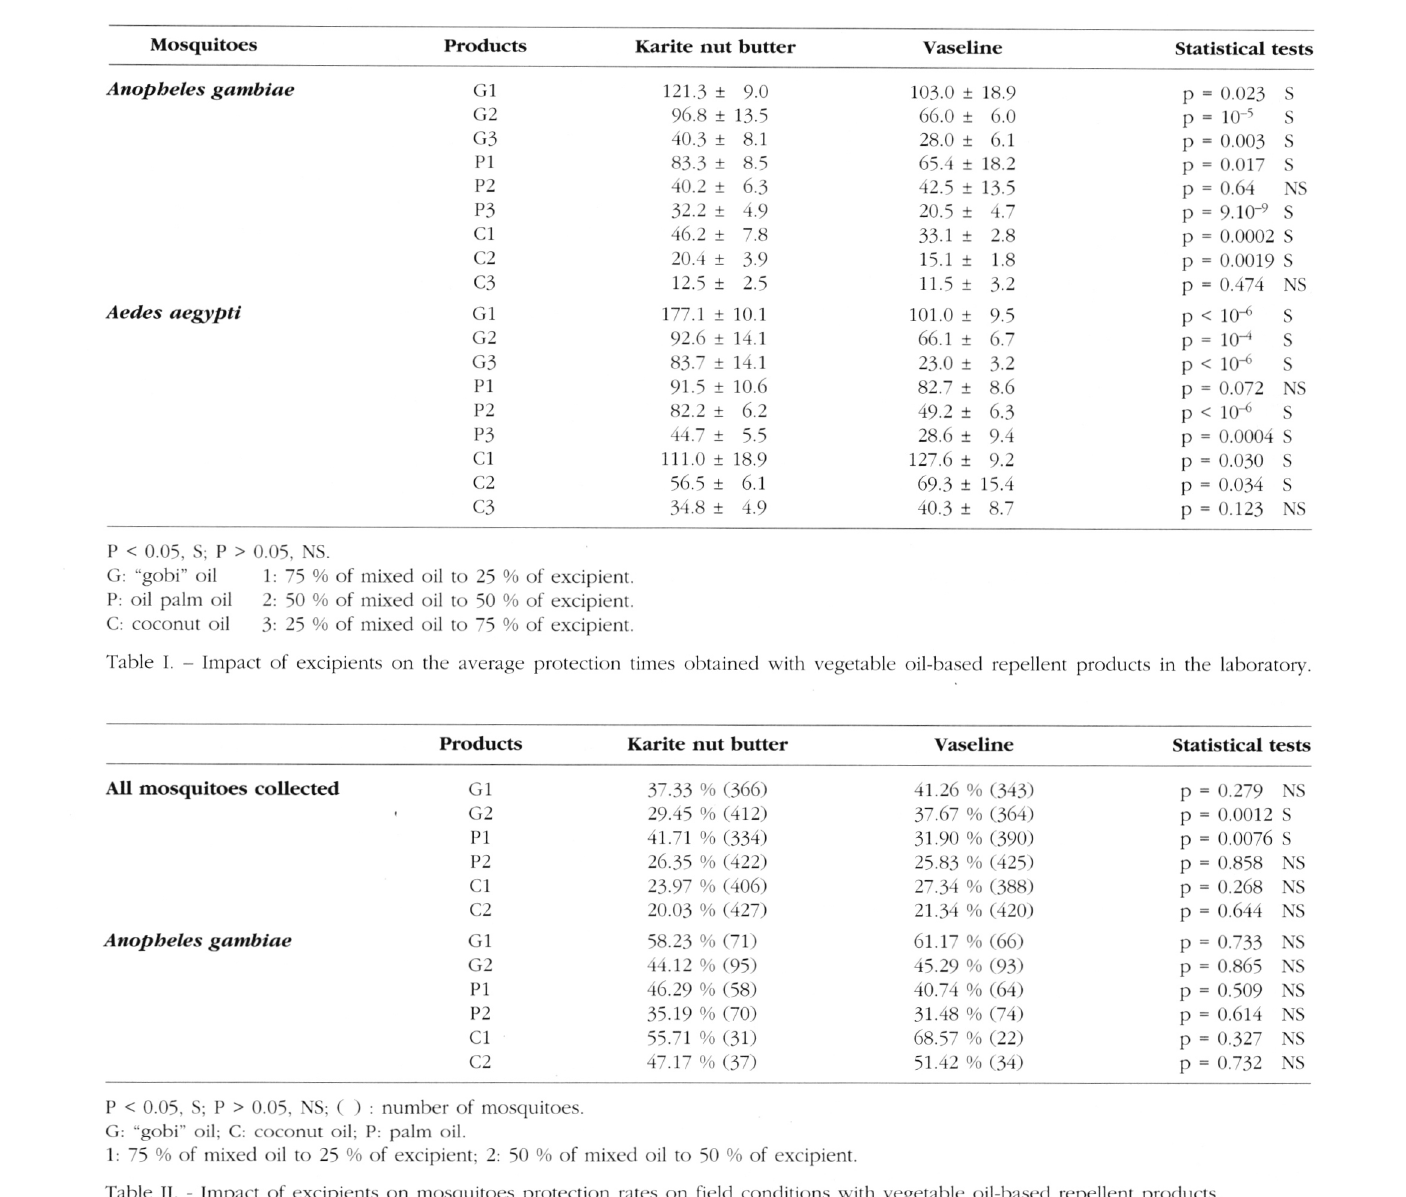
Table II. - Impact of excipients on mosquitoes protection rates on field conditions with vegetable oil-based repellent